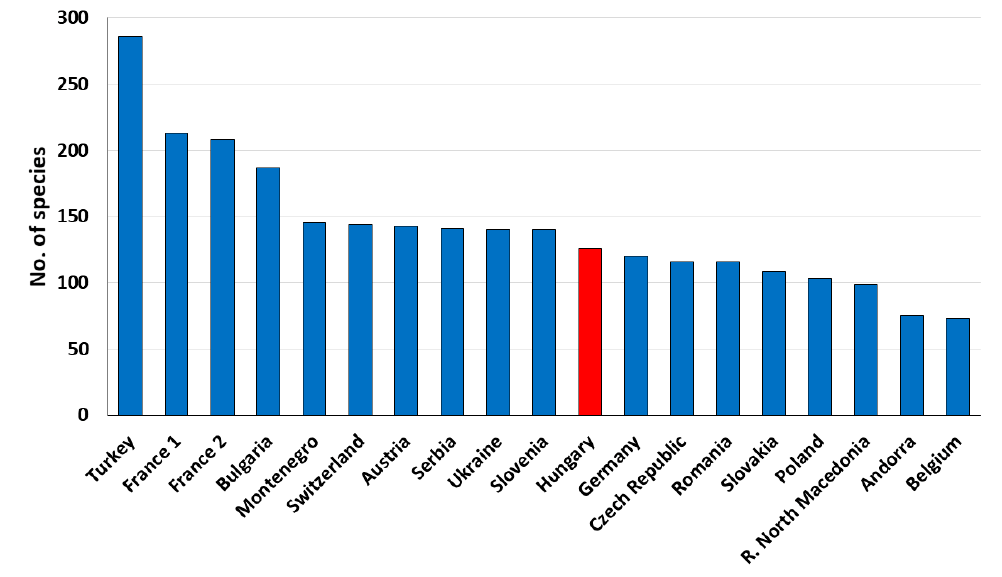
Figure 1. The number of known ant species in other European countries (Turkey: [17]; France 1: [20]; France 2: [19]; Bulgaria: [78]; Montenegro: [21]; Switzerland: [23]; Austria: [23]; Serbia: [79]; Ukraine: [14]; Slovenia: [80]; Germany: [23]; Romania: [13,16,32,81]; Czech Republic: [82]; Slovakia: [83]; Poland: [15]; Republic of North Macedonia: [84]; Andorra: [18]; Belgium: [85]).